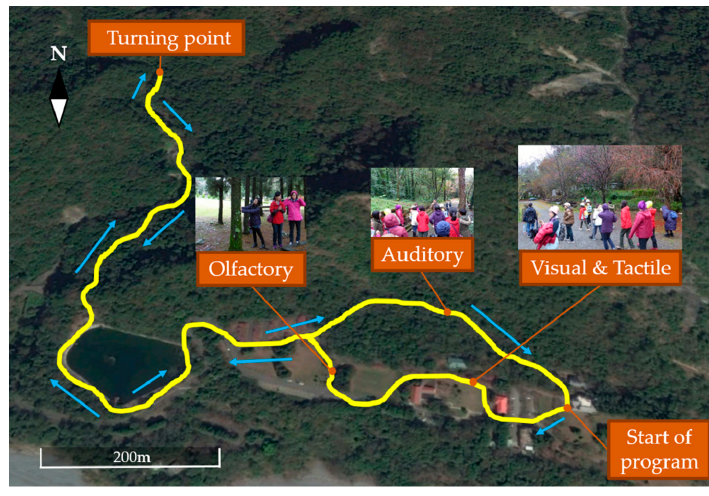
Figure 1. The route of guided forest walk.